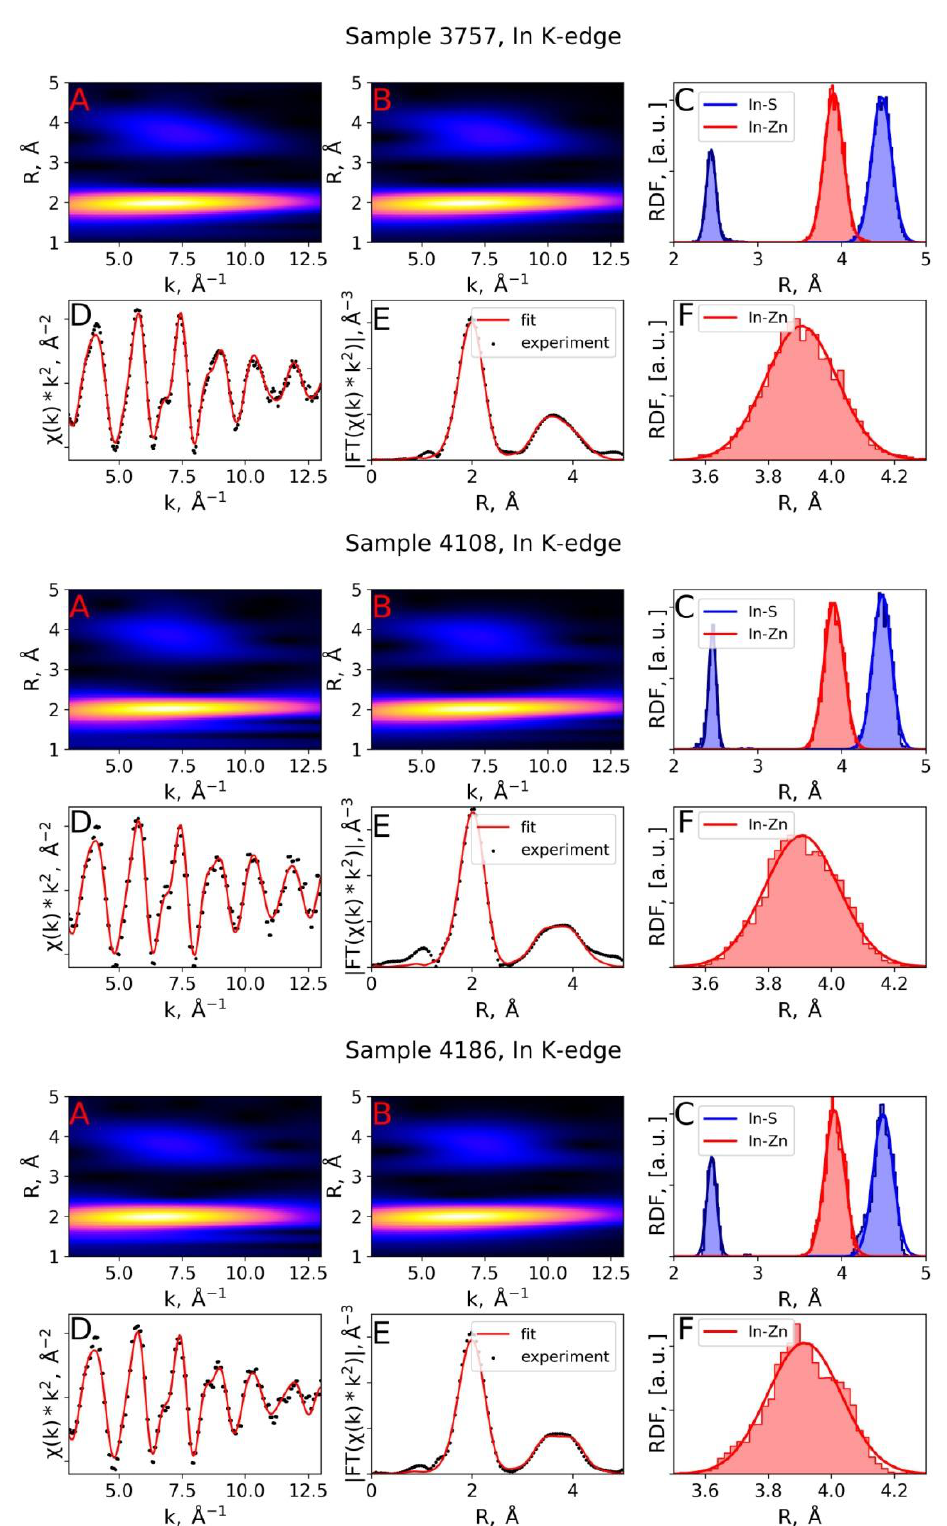
Figure 2. The RMC fit results of In K -edge EXAFS spectra for Samples 3757 (doped with In), 4108, and 4186 (doped with In and Cu). Panel A: experimental WT image; panel B: fitted WT image; panel C: calculated RDF for first three coordination shells around absorbing atom; panel D: experimental (black dotted line) and fitted (red solid line) EXAFS signal χ(k)*k 2 ; panel E: Fourier transform magnitudes of experimental (black dotted line) and fitted (red solid line) χ(k)*k 2 function; panel F: close view of In-Zn RDF. The RDFs fitted by Gaussians are shown by solid lines.